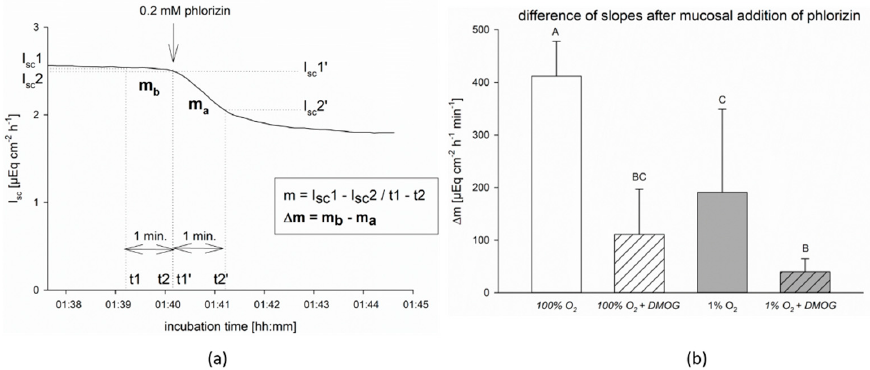
Figure 1. Activity of sodium-coupled glucose transporter SGLT1 in isolated lagomorph jejunum epithelia under hypoxia and preincubation with DMOG. After equilibration in the bu ff er solution, half of the epithelia were preincubated with 2 mM DMOG for 15 min. Subsequently, part of the control and part of the DMOG group was subjected to ‘hypoxia’. After 45 min of ‘hypoxia’, 0.2 mM phlorizin was added to the mucosal bu ff er solution and the slopes of I sc for one minute before (m b ) and after (m a ) the addition were calculated as outlined in the Materials and Methods section and exemplified on the left hand ( a ). The di ff erence in the slopes ( ∆ m = m b − m a ) after mucosal addition of phlorizin (i.e., the e ff ect of SGLT1 inhibition) was calculated and compared between the treatment groups. ( b ) shows that ∆ m was decreased by ‘hypoxia’ (grey bars) compared to the control group gassed with 100% oxygen (white bars) and also by preincubation with DMOG (hatched bars). Bars represent mean ± SD; one-way repeated measurements ANOVA with a subsequent Holm–Sidak test based on N = 6 (animals) ( n = 10 (epithelia)), p < 0.05, di ff erent letters indicate significant di ff erences between